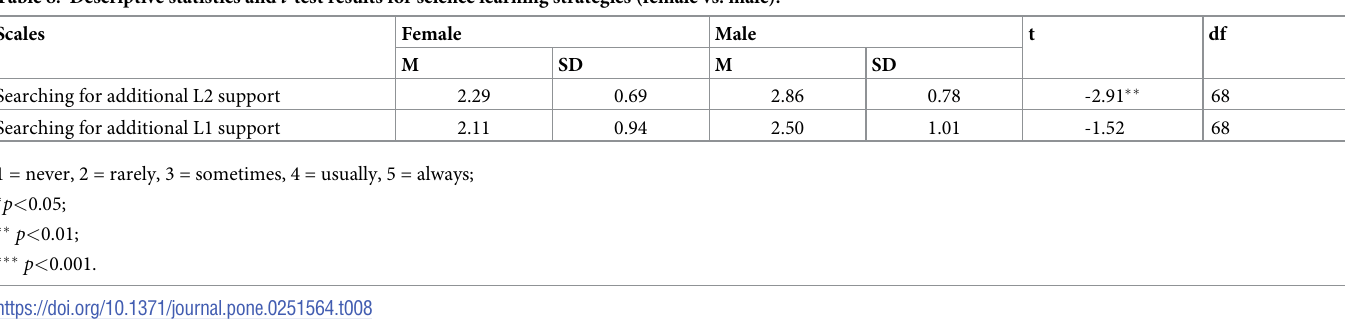
Table 8. Descriptive statistics and t -test results for science learning strategies (female vs. male).